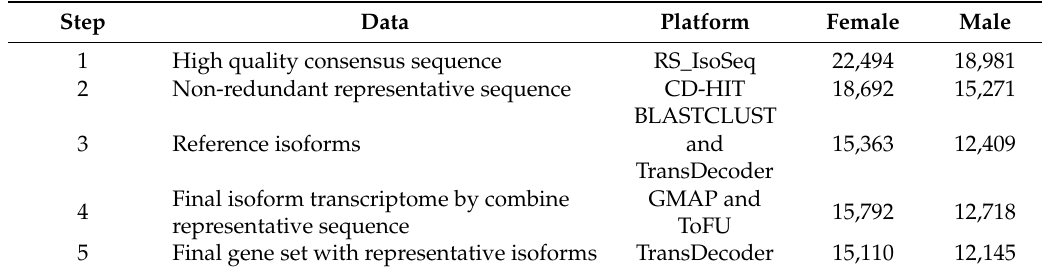
Table 1. Platforms for establishing gene sets of female and male Haliotis discus hannai